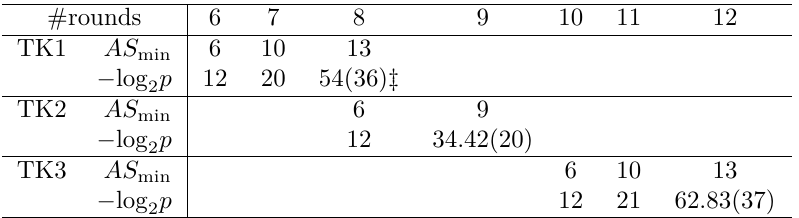
Table 7: Bounds on the number of active Sboxes and probability of trails in SKINNY-128 under related-tweakey